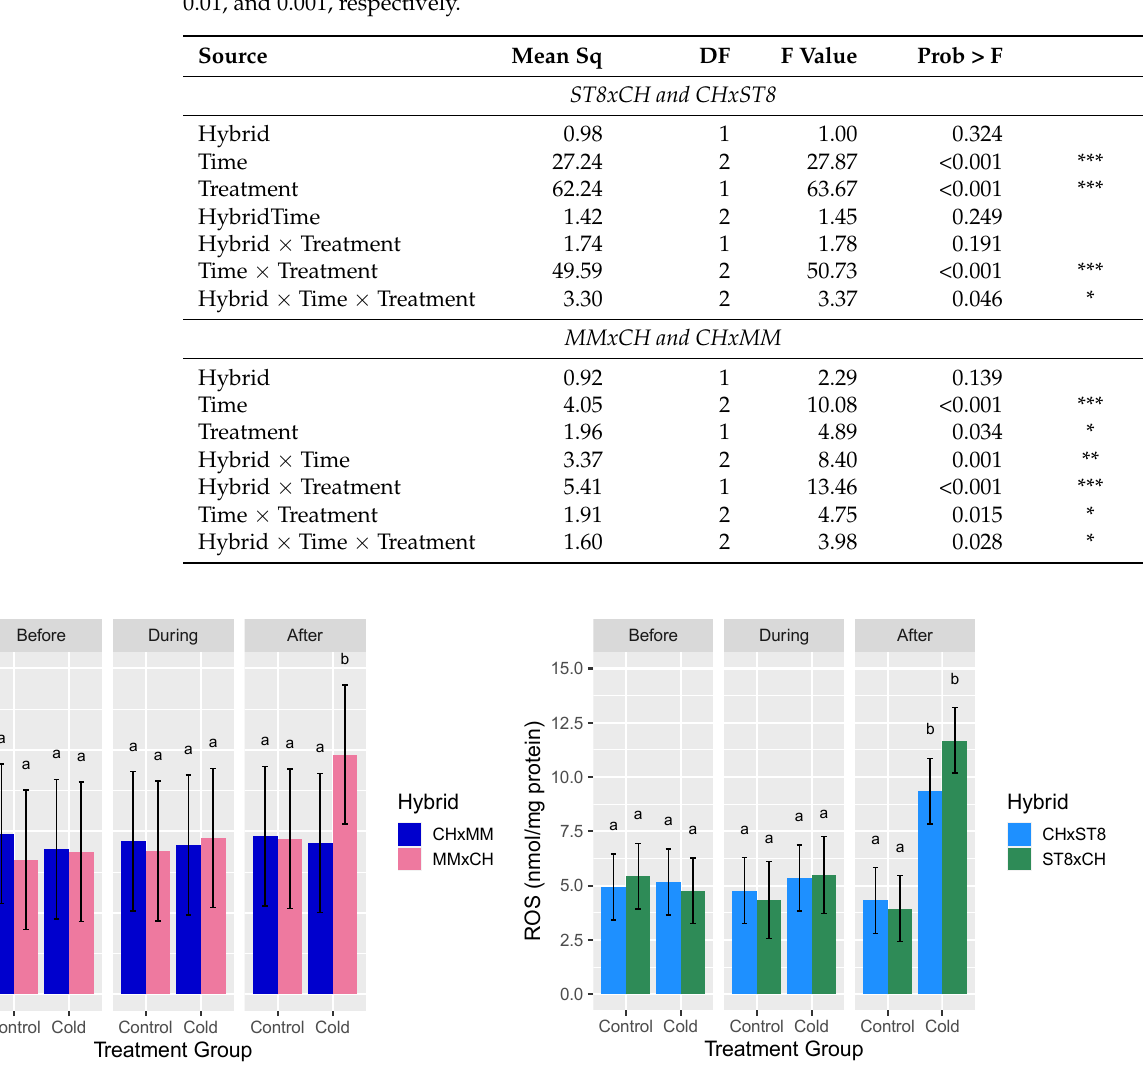
Figure 3. Mean reactive oxygen species (ROS) hydrogen peroxide (H 2 O 2 ) level relative to total protein content (nmol/mg protein) of apical meristem and young leaf tissue of reciprocal hybrids directly before cold treatment, at hour 3 during cold treatment, and 24 h after cold treatment. Plants were grown in a greenhouse at 28 °C for 10–12 days then cold treated at 4 °C for 5.5 h at a light intensity of 270 µmol·s − 1 ·m − 2 (Cold) or remained in the greenhouse (Control). Error bars represent least-square means 95% CI and different letters indicate significantly different hybrid means across treatment combinations based on Tukey HSD test ( p < 0.05) . for Cold Tolerance Mapped reads from sequencing of cpDNA from DHs CH, ST8, and MM had an av- erage coverage depth of 2314, 2165, and 1056 reads at each nucleotide position,